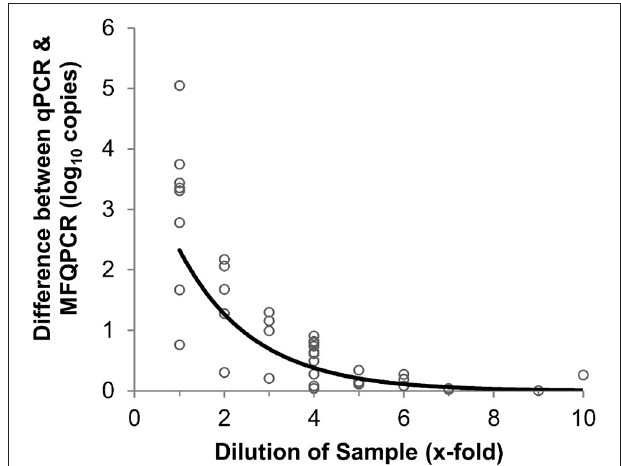
FIGURE 3 | Effect of sample dilution on accuracy of MFQPCR copy number estimates. Large discrepancies between qPCR and MFQPCR estimates are evident when gDNA soil extracts are diluted 4-fold or less. Data points are a combination of estimates for amoA2 and narG under Set B assay conditions (summarized in Table 2